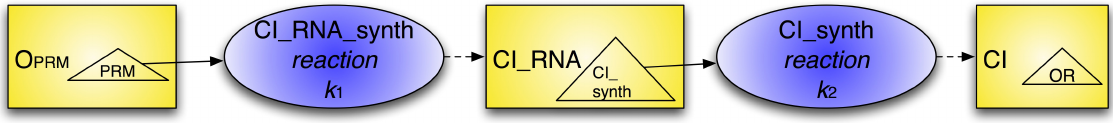
Figure 1: A MIN model representing the CI synthesis. The regulatory sites CI RNA synth and CI synth represent non reversible reactions of CI RNA synthesis and of CI protein synthesis. They have the attributes k 1 and k 2 , respectively, which represent the reaction rates measured in or calculated from biological experiments. The ICRs coming out from the species O PRM and CI RNA have the attributes stoichiometry = M (not shown in this figure), meaning that these species are not consumed in these reactions: they are biological matrices, or ”templates” for the macromolecular synthesis.